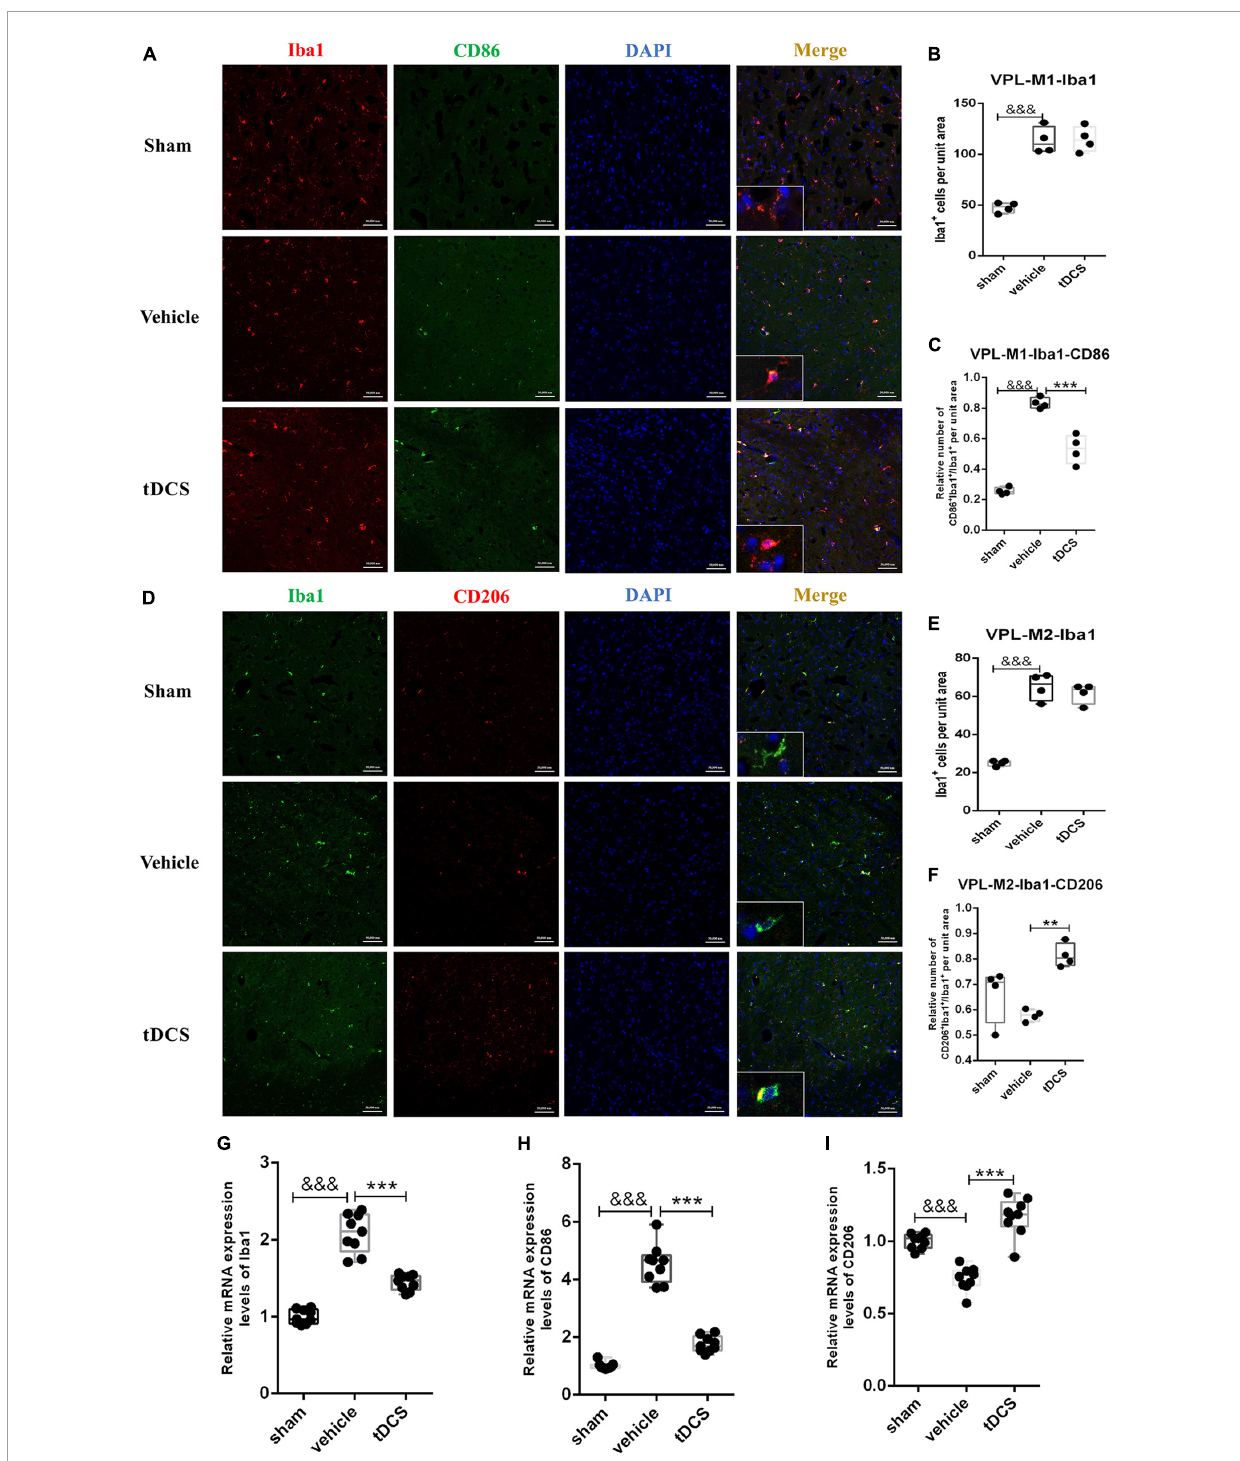
FIGURE4 tDCS alters the direction of microglial polarization in the thalamic VPL region. (A) Iba1 and CD86 protein immunofluorescence co-staining in three groups. Iba1 protein was stained with red fluorescence, and CD86 protein was stained with green fluorescence. Nuclei were labeled with blue fluorescence. Merged pictures show positive cells. Bar = 50 µ m. (B) Statistical analysis results of the expression of Iba1 in microglia of each group. (C) Statistical analysis results of the proportion of CD86 and Iba1 positive cells to Iba1 positive cells in microglia of each group. (D) Iba1 and CD206 protein immunofluorescence co-staining in three groups. Iba1 protein was stained with green fluorescence, and CD206 protein was stained with red fluorescence. nuclei were labeled with blue fluorescence. Merged pictures show positive cells. Bar = 50 µ m. (E) Statistical analysis results of the expression of Iba1 in microglia of each group. (F) Statistical analysis results of the proportion of CD206 and Iba1 positive cells to Iba1 positive cells in microglia of each group. (G–I) Relative mRNA expression levels of Iba1, CD86, and CD206 in each groups, as detected by qRT-PCR. Vehicle group vs. sham group, &&& p < 0.001; tDCS group vs. vehicle group, *** p < 0.001 and ** p < 0.01, n =